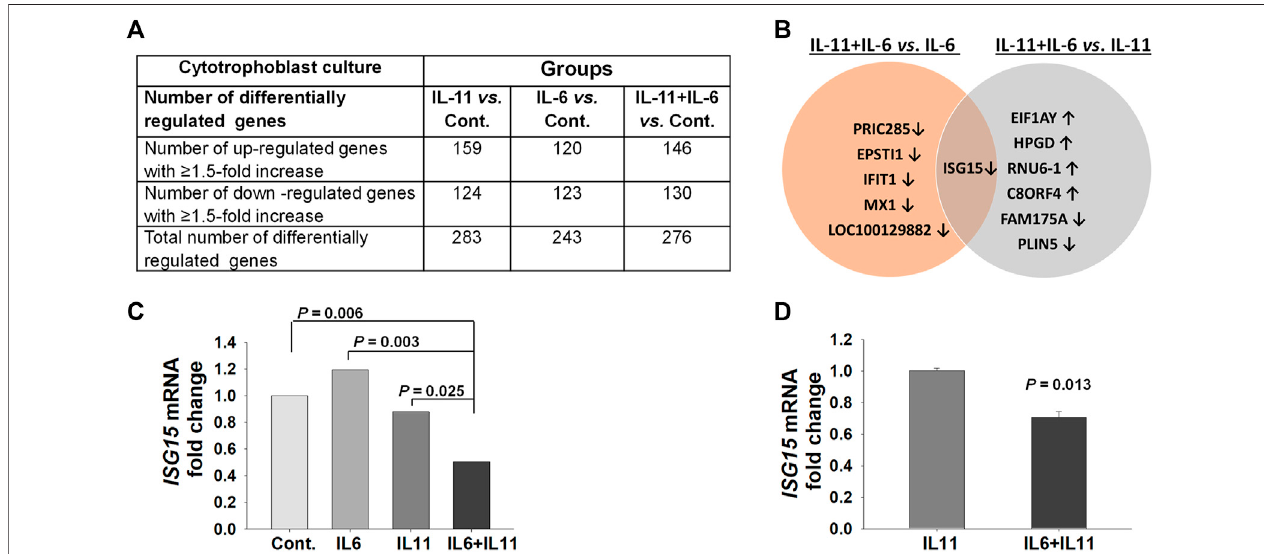
FIGURE1| Microarray analysisidenti fi esthe ISG15 transcriptasacommon, differentiallyregulated,geneinprimary cytotrophoblastculturesco-treated withIL-11 and IL-6. (A) Number ofgenesdifferentially regulated by treatment witheither IL-11 (10 ng/ml) or IL-6 (10 ng/ml) or IL-11 + IL-6 vs. control (Cont.) in cytotrophoblast cell cultures for 6 h. (B) Genesdifferentially regulated byIL-11 + IL-6 co-treatment versus treatment with IL-6 or IL-11separately. (C) Graph represents fold changes in pair- comparison of microarray data for ISG15 mRNA in control, IL-6, and IL-11 vs. IL-11 + IL-6 treatment groups ( n = 3). (D) ISG15 mRNA expression levels by RT- qPCR analysis; bars represent Mean ± SEM and compared by using t -test, n = 3 with triplicates for each experiment.